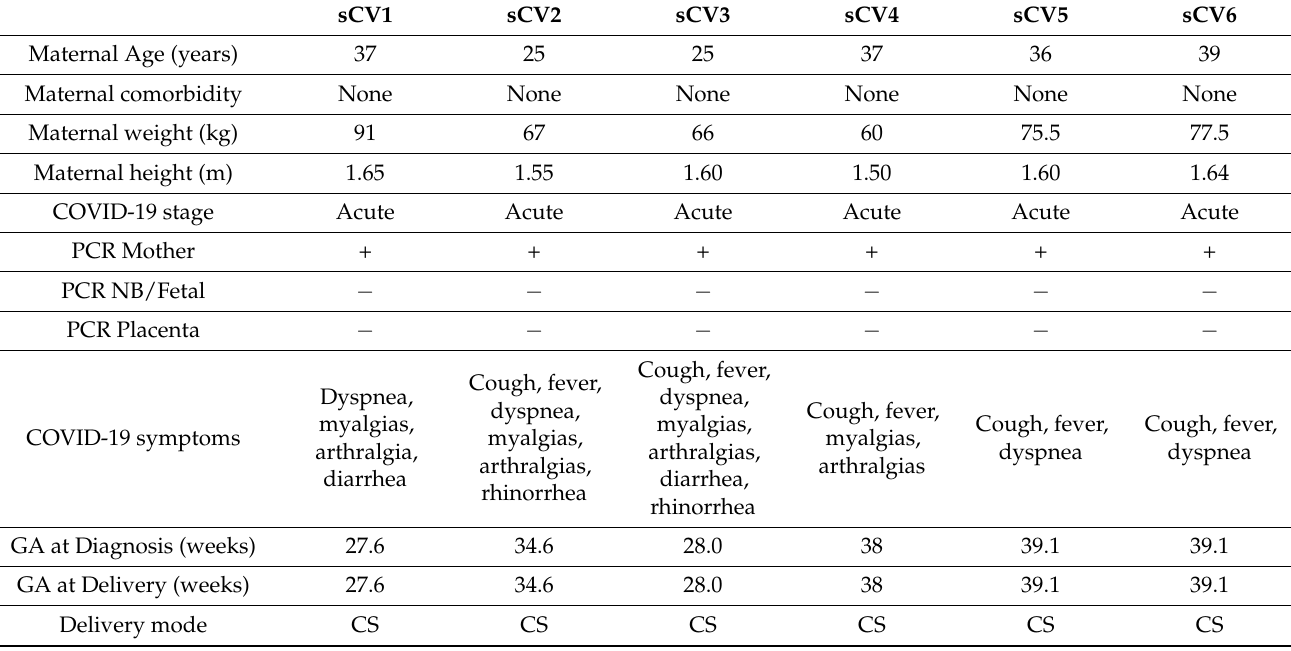
Table 3. Clinical data of women with severe COVID-19 and their